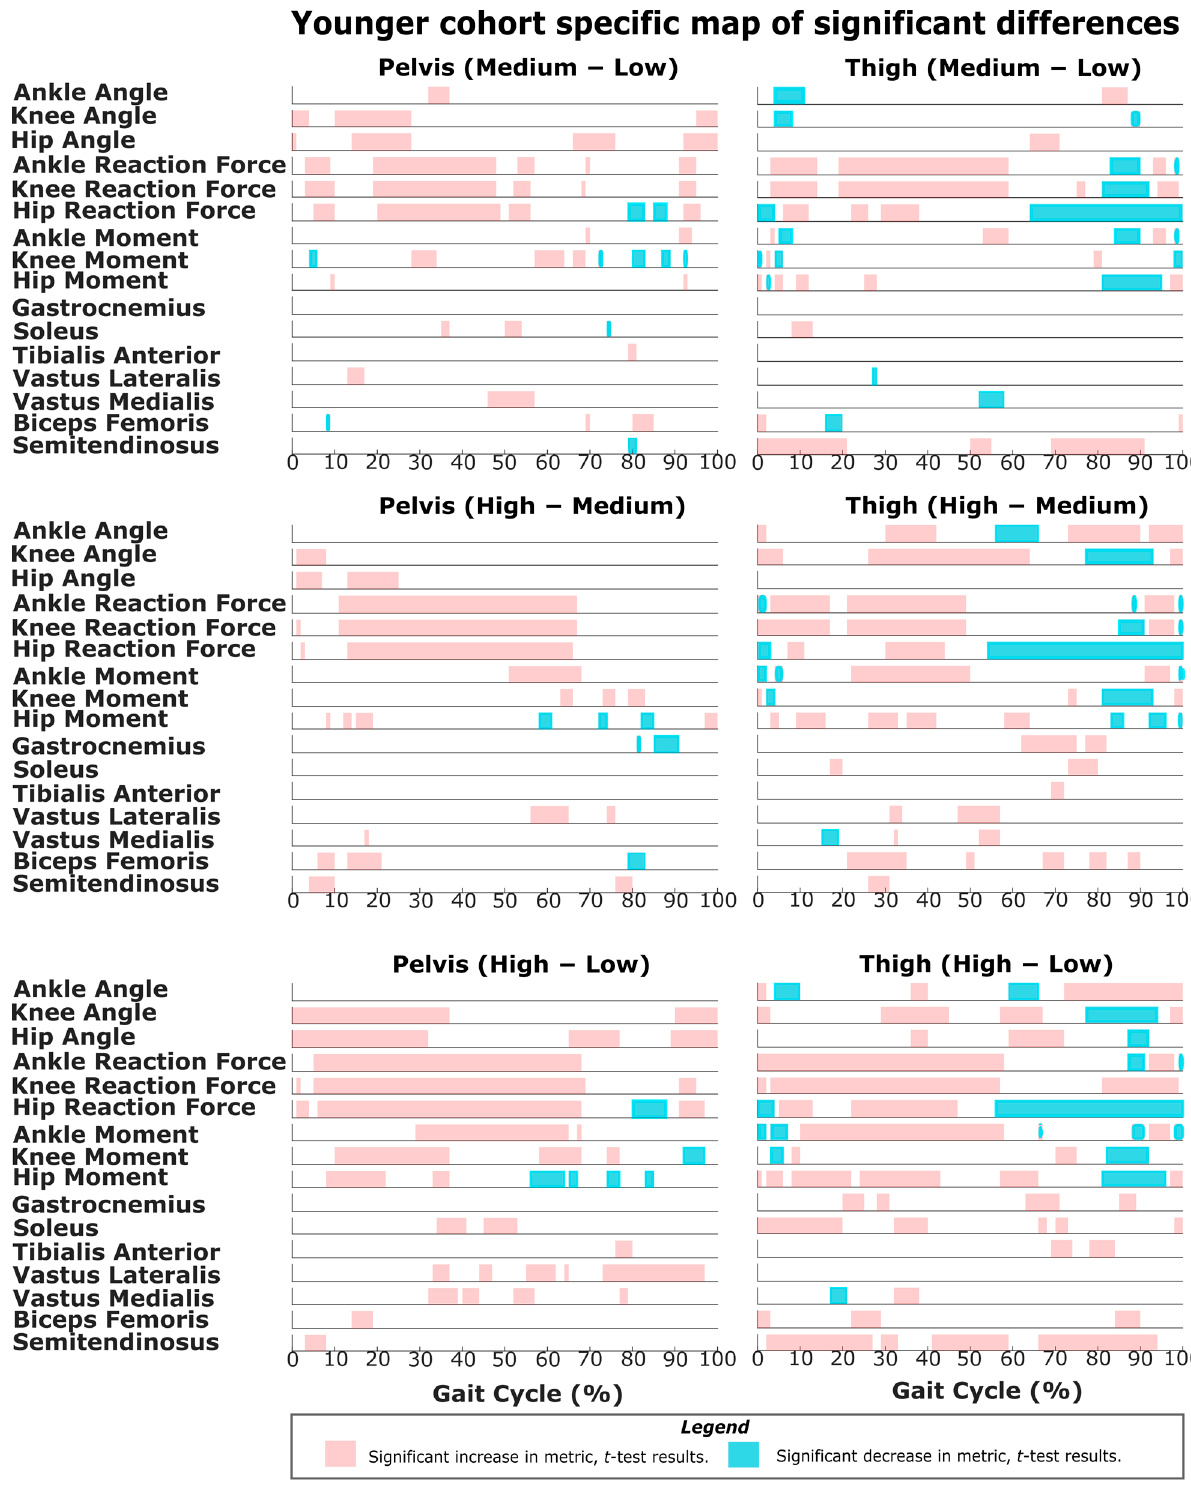
Figure 3. Map of all the SPM results for younger adults. Column 1 contains the results from the t -test for a full-factorial comparison of the pelvis masses. Column 2 contains the results from the t -test for a full-factorial comparison of the thigh masses. An increase in the metric (higher weight causes more ‘+’ve change) is highlighted in red, and a decrease in the metric (higher weight causes more ‘ − ’ve change) is highlighted in blue. Results from row 3 are also represented in Figures 5, 7 and 9 to indicate regions of significant differences.